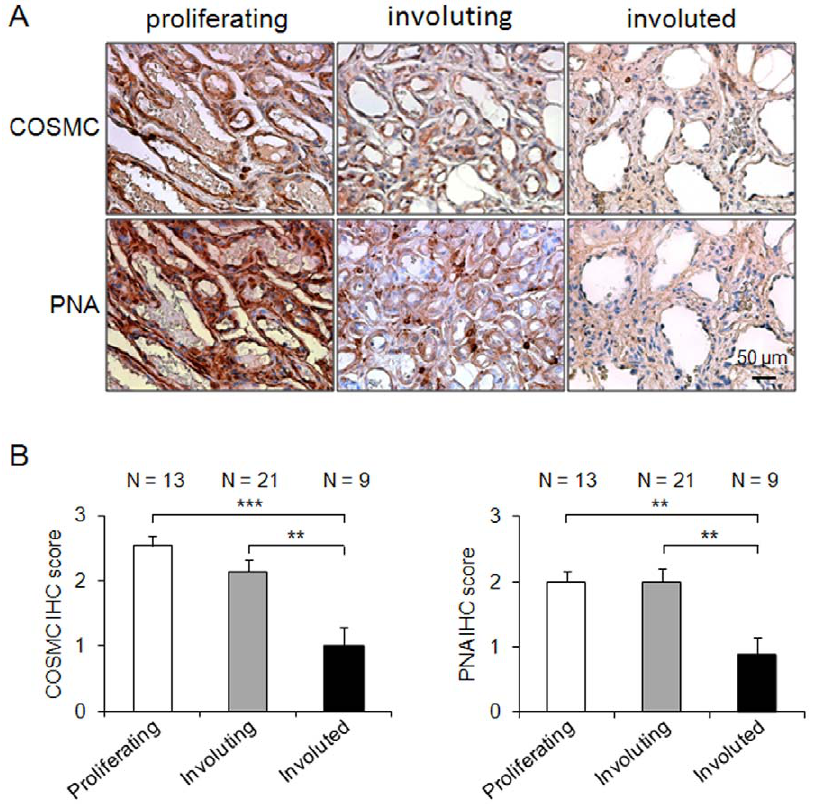
Figure 1. COSMC is overexpressed in proliferating hemangiomas. (A) Immunohistochemistry of human hemangioma tissues. Paraffin- embedded hemangiomas in proliferating (N=13), involuting (N=21), and involuted (N=9) phases were immunostained with anti-COSMC antibody or biotin-conjugated peanut agglutinin (PNA). Representative images are shown. Scale bars: 50 m m. Negative controls did not show specific staining (data not shown). (B) COSMC is overexpressed in proliferating and involuting hemangiomas compared with involuted hemangiomas. Intensity of immunostaining was quantified. N=patient numbers. Data are presented as means 6 SEM. ** P , 0.01; *** P , 0.001.